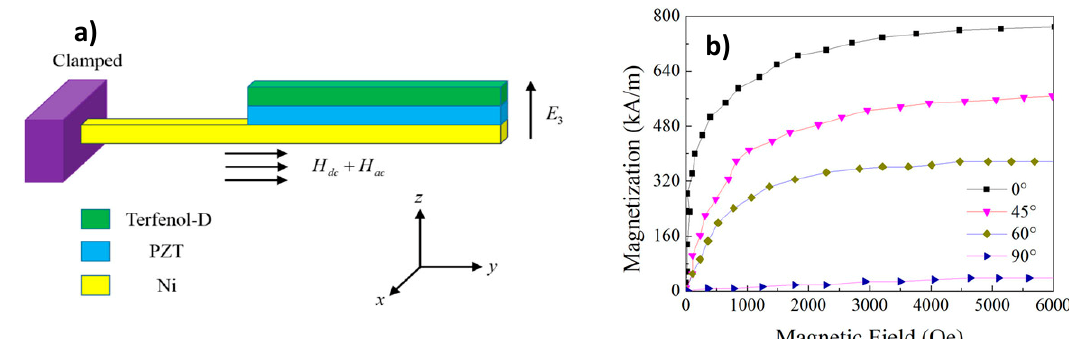
Figure 8. ( a ) The configuration of laminated Terfenol-D / PZT / Ni composite cantilever; ( b ) magnetization of Terfenol-D with bias field at different orientation angles. Reproduced with permission from [56].